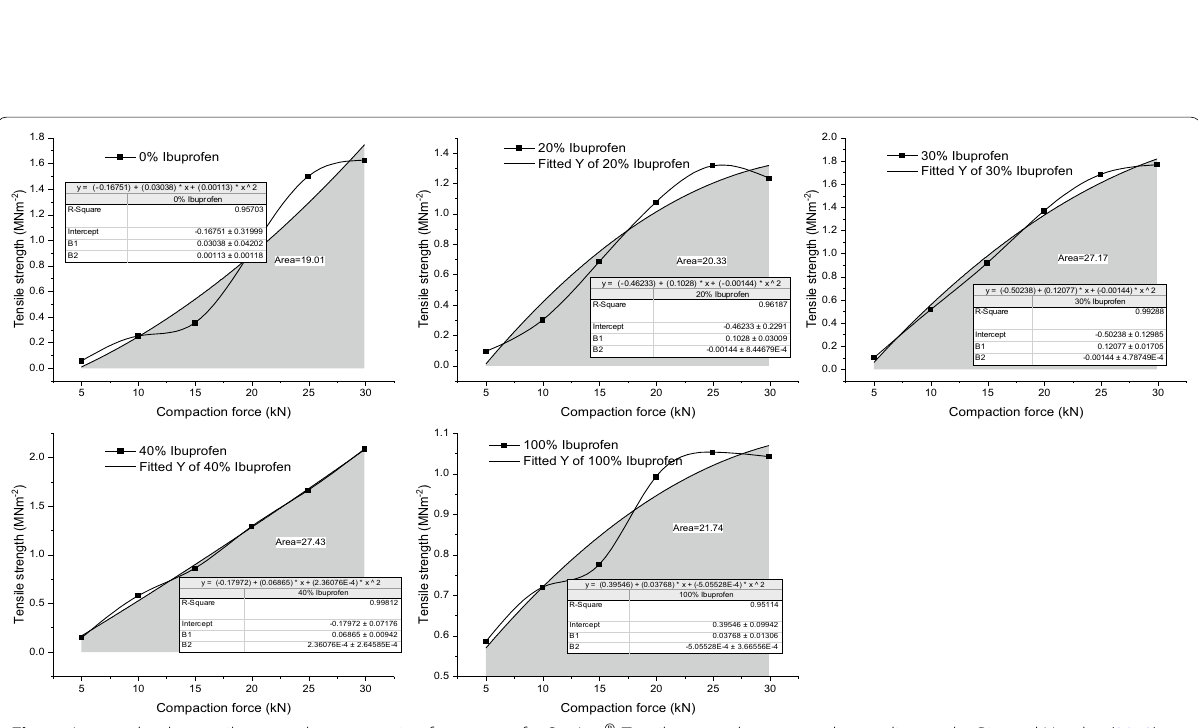
Fig. 7 Area under the tensile strength–compaction force curve for StarLac ® . Tensile strength computed according to the Pitt and Heasley (2013)